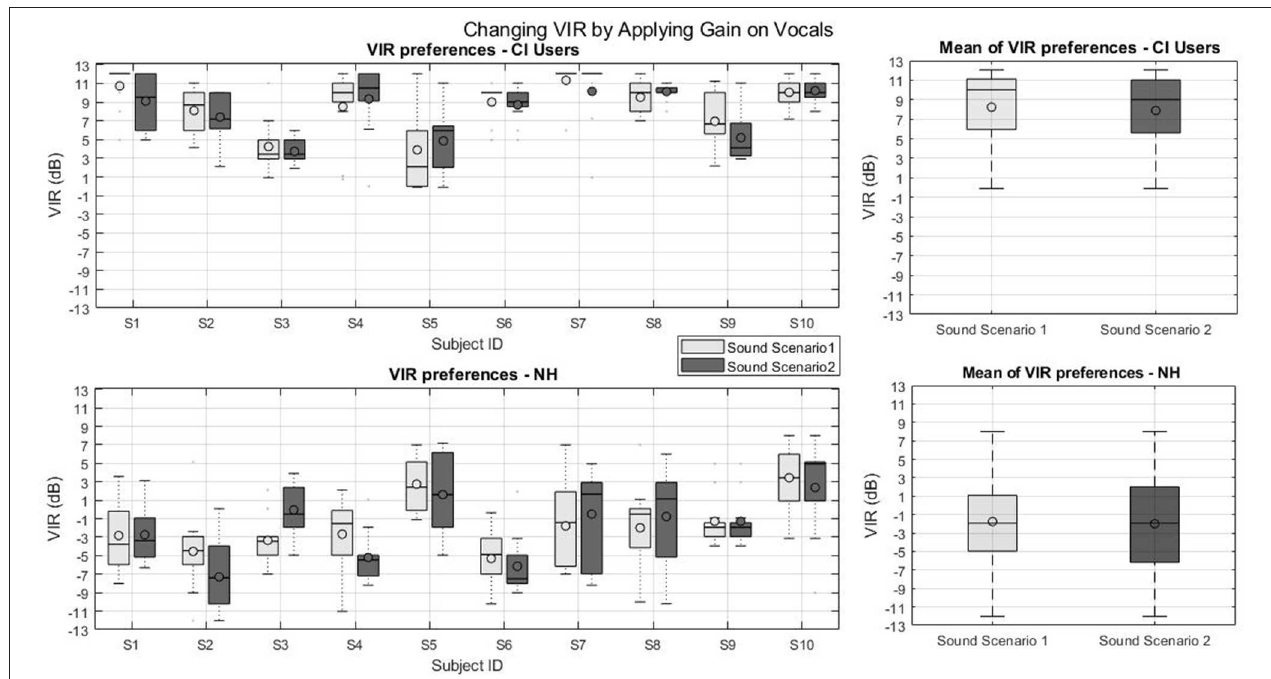
FIGURE 4 | VIR values from part one of experiment 1: Changing VIR by applying gain on vocals. (Top left) VIR preferences of CI users, (Top right) mean VIR of CI users, (Bottom left) VIR preferences of NH subjects, (Bottom right) mean VIR of NH subjects.